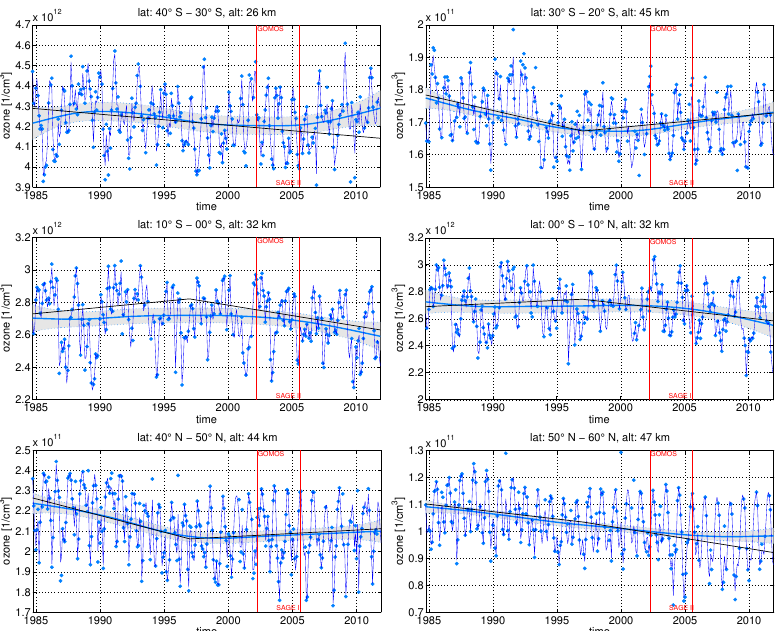
Figure 10. Comparing DLM and the linear model. Six examples of DLM vs. piecewise linear model fits using data with 1km altitude resolution. The solid black line is the piecewise linear trend from Kyrölä et al. (2013). The smooth solid blue line is the background level component of the DLM model with 95% probability envelope. At 40–50 ◦ N and 44km the methods agree. In the other panels we see differences of various degrees.